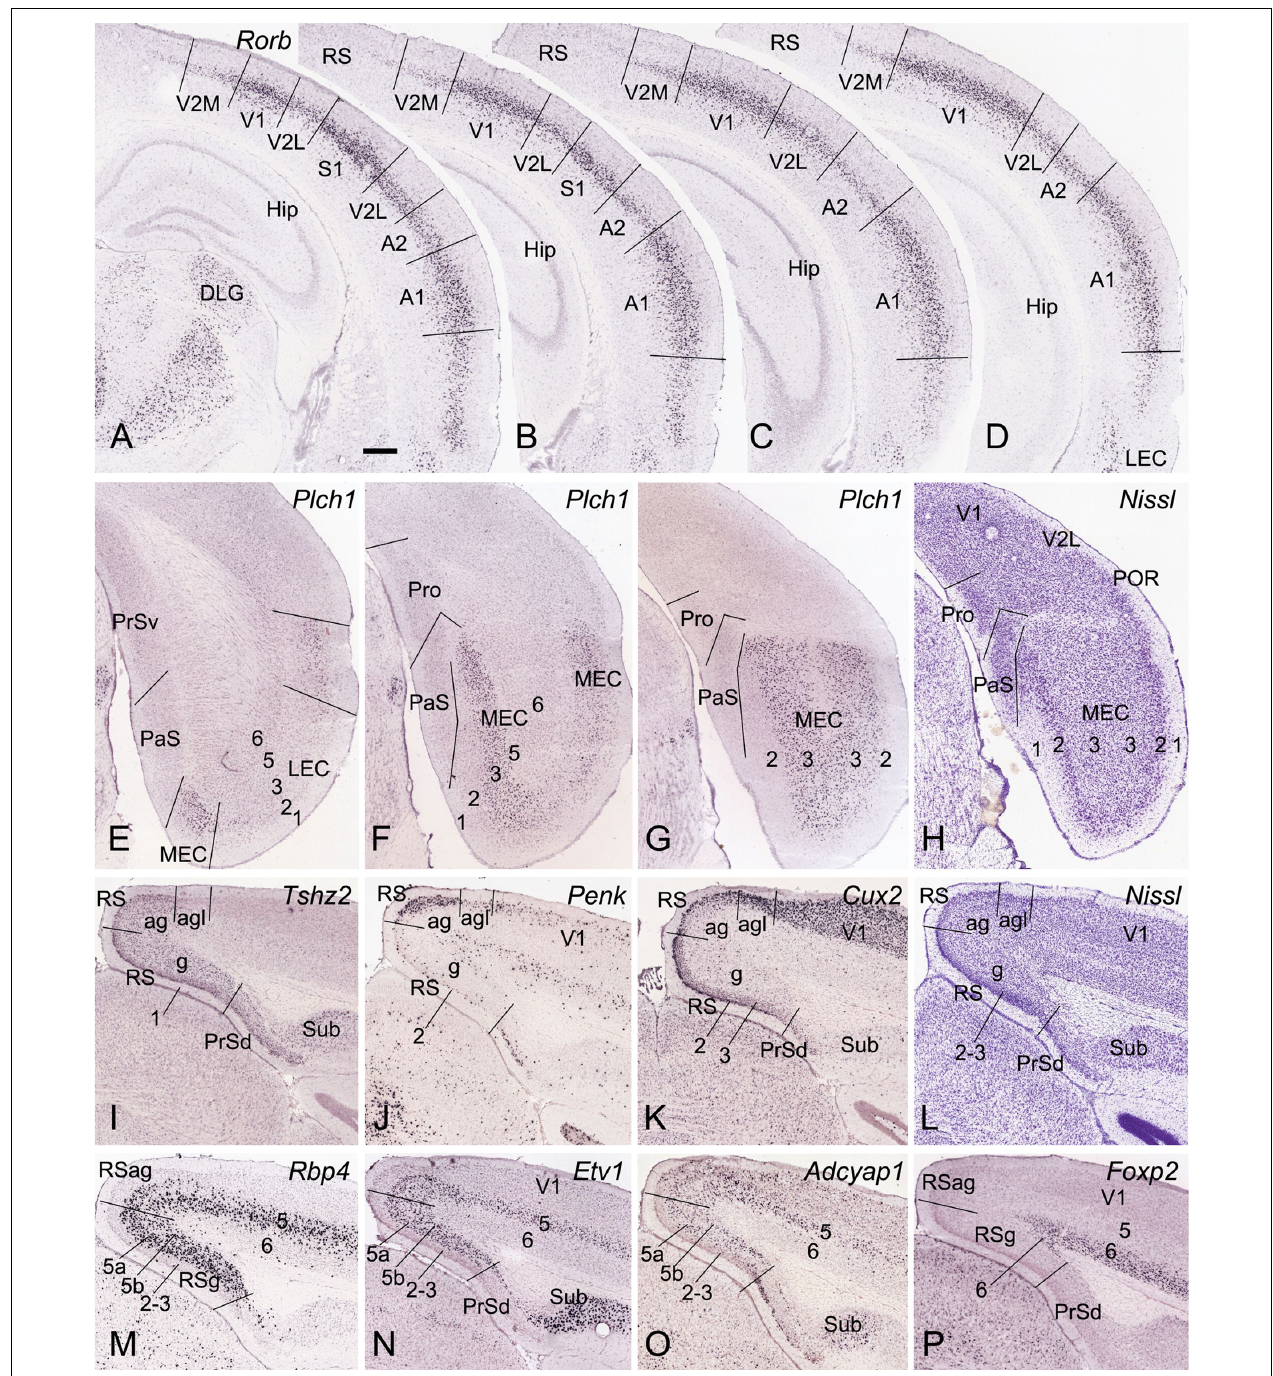
FIGURE 2 | Locations and subdivisions of visual, auditory, entorhinal, and retrosplenial cortices. Panels (A–G) and (I–K) are ISH-stained sections while panels (H,L) are Nissl-stained sections. (A–D) Four rostral (A) to caudal (D) coronal sections showing Rorb expression in L4 of the primary and secondary visual and auditory cortices (V1, V2M, V2L, A1, and A2) as well as in the caudal S1. Note the strong and moderate Rorb expression in the primary (V1, S1, and A1) and secondary/association (A2, V2M, V2L) sensory cortices, respectively. No or little Rorb expression is seen in the RS. ( E–G) Three rostral (E) to caudal (G) sections showing little and strong Plch1 expression in L3 of the lateral and medial entorhinal cortex (LEC and MEC), respectively. (H) A Nissl-stained section showing the locations of the Pro, PaS, and L2 of the MEC. ( I–L) Four sections stained respectively for Tshz2 (I) , Penk (J) , Cux2 (K) , and Nissl (L) showing the locations of three RS subdivisions (RSg, RSag, and RSagl), which display differential molecular signature and cytoarchitecture. (M–P) Four sections stained respectively for Rbp4 (M) , Etv1 (N) , Adcyap1 (O) , and Foxp2 (P) showing lamination of the RS. Note the thick L5 in the RS, which can be subdivided into 5a and 5b. Bar: 350 µ m in panel (A) (for all